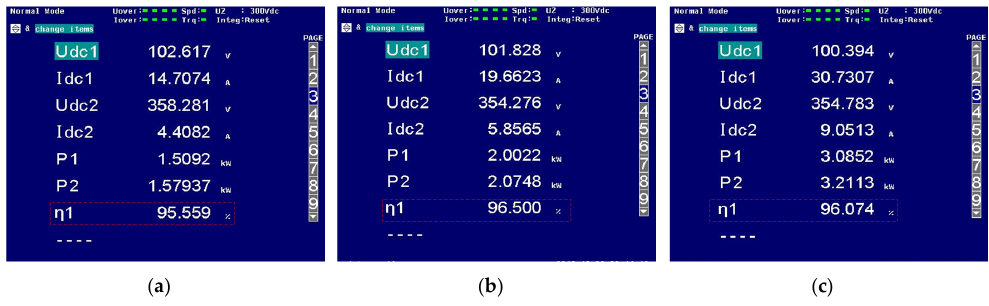
Figure 14. Efficiency measurement of the proposed PSFB converter. ( a ) Efficiency with the temperature balancing in progress. ( b ) Maximum efficiency of the converter. ( c ) Efficiency for the maximum rated output.